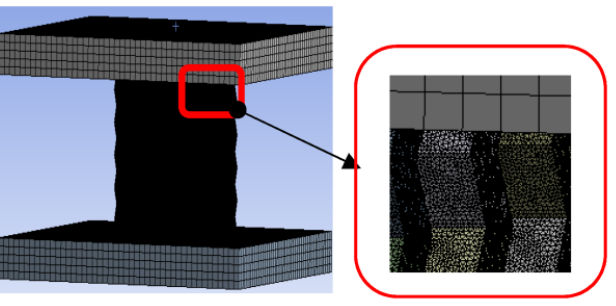
Figure 2. Meshing. Figure 2. Meshing.